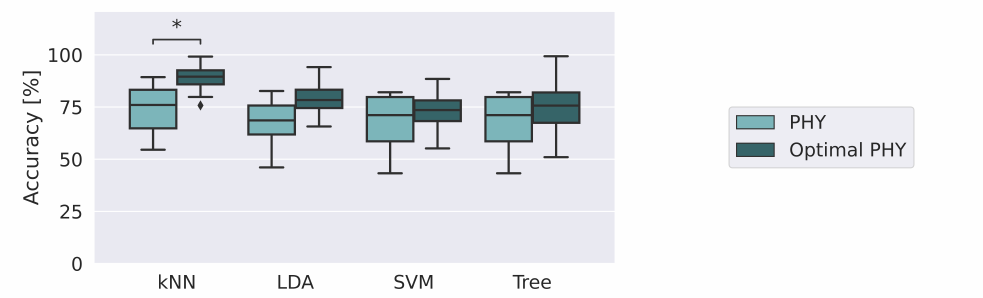
Figure 8. Accuracy returned by the classifiers in identifying risk by using physiological data and the optimal feature set, i.e., PHY and Optimal PHY datasets, respectively. The * denotes comparisons in which p -value ≤